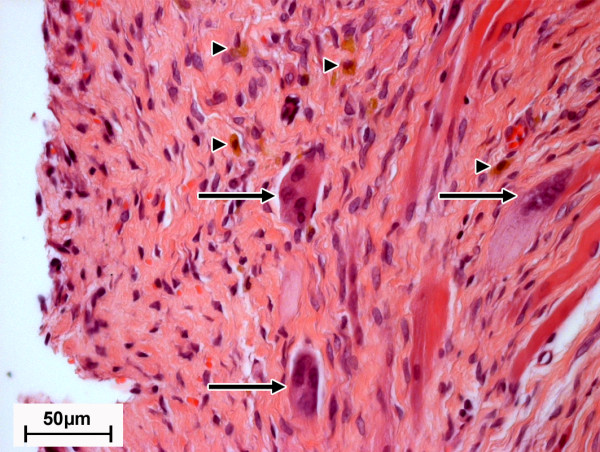
Image section of the periimplant fibrous tissue of an MgCa0.8 screw four weeks postoperatively (H. E., 400×). Within the fibrous tissue mild infiltrations of giant cells (arrows) and macrophages (triangles) are detectable.